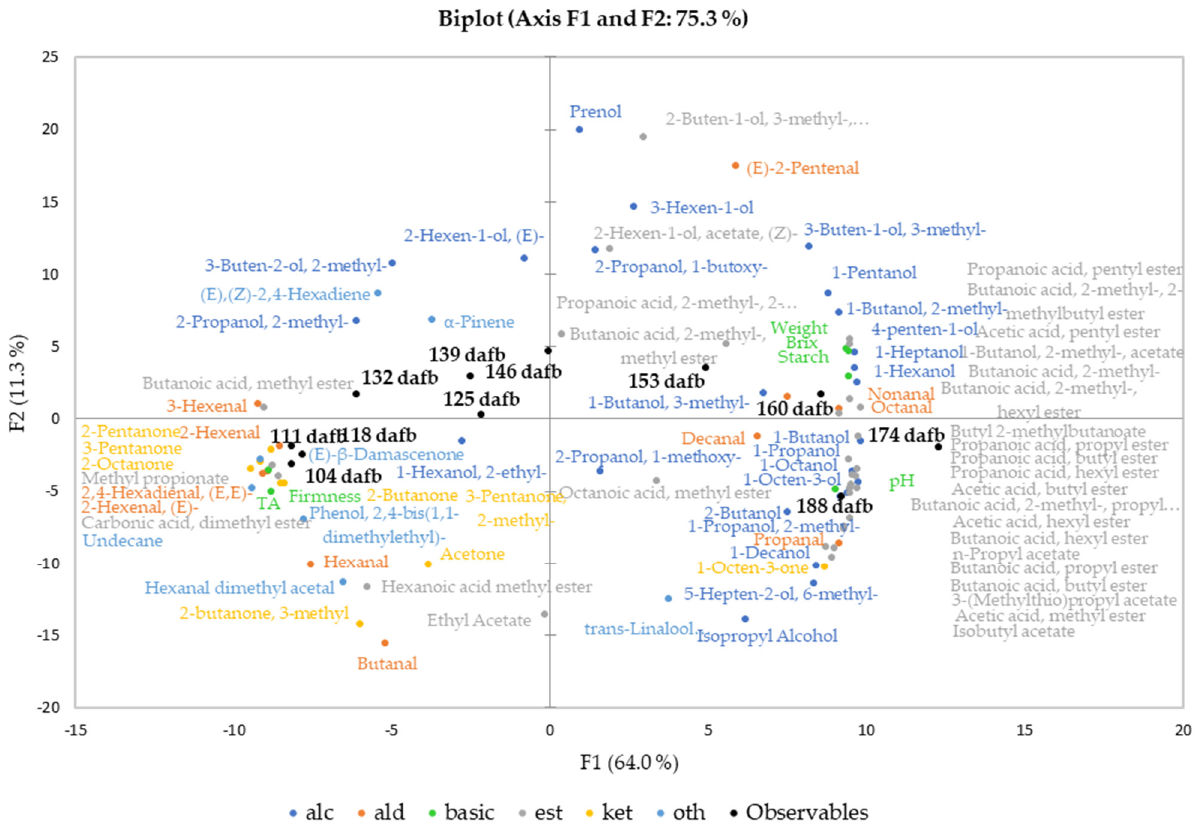
Figure 2. Principal component analysis (PCA, Pearson correlation) biplot of basic fruit quality attributes and the volatilome (2 ◦ aroma compounds) of Crimson Crisp apples (variables) and the harvest date (observables). The harvest dates (observables) are black and form a clockwise pattern starting in quadrant III, passing through II and I and ending in IV.